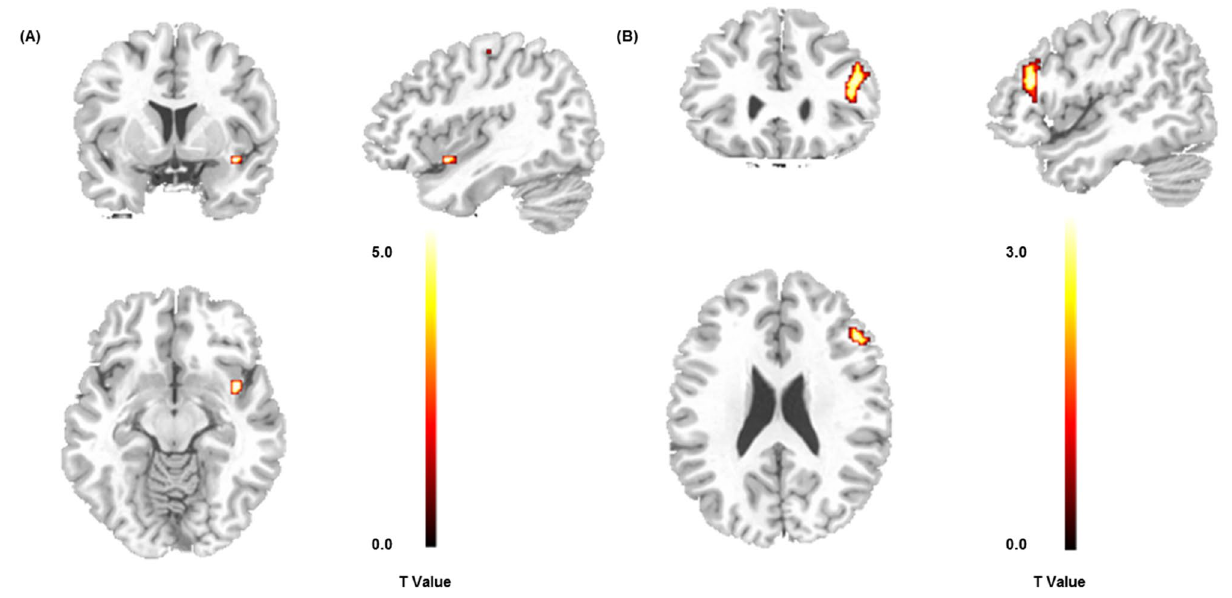
Figure 2. ( a ) Areas showing stronger BOLD-responses for controls vs. patients across all feedback conditions (regular fMRI; significance level: p (FWE) < 0.05). ( b ) Areas showing theta-band associated activation for the group × valence (loss) interaction (theta power coupling with BOLD activity; single-voxel p < 0.005, k ≥ 100). This figure was created using SPM12 45 (Version 12; www. fil. ion. ucl. ac. uk/ spm/ softw are/ spm12/) and MRIcro 49 (Version 1.40; people.cas.sc.edu/rorden/mricro/).